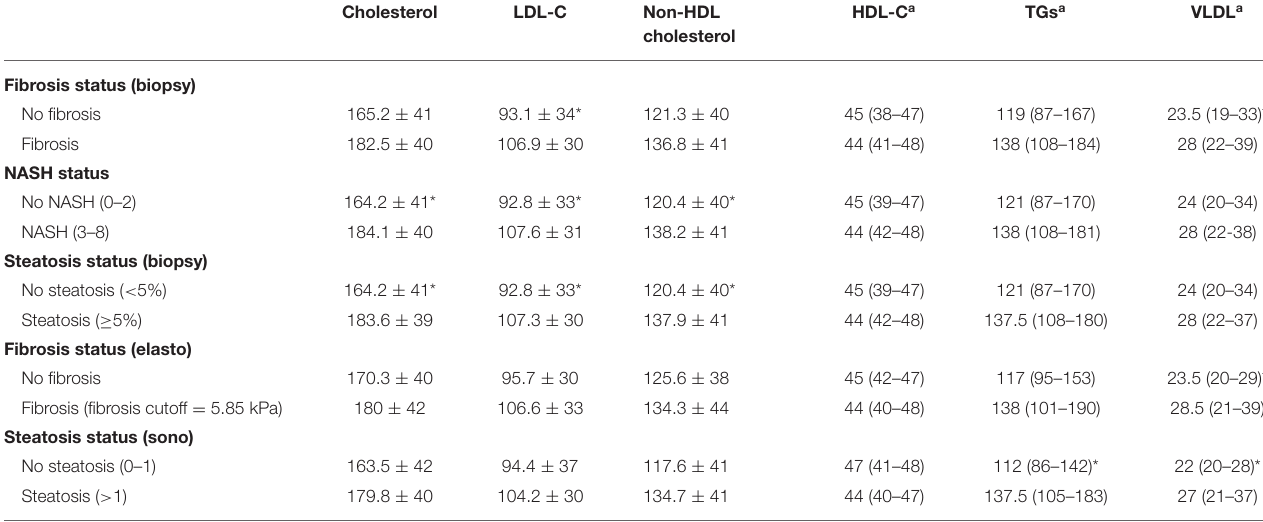
TABLE 2 | The comparison of serum parameter concentration between study